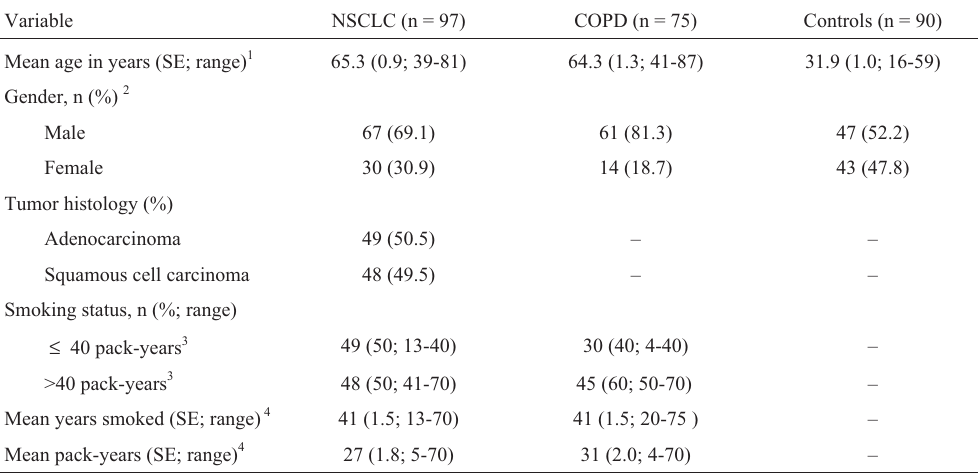
Table 2 - Main characteristics of the patients sampled in this study.